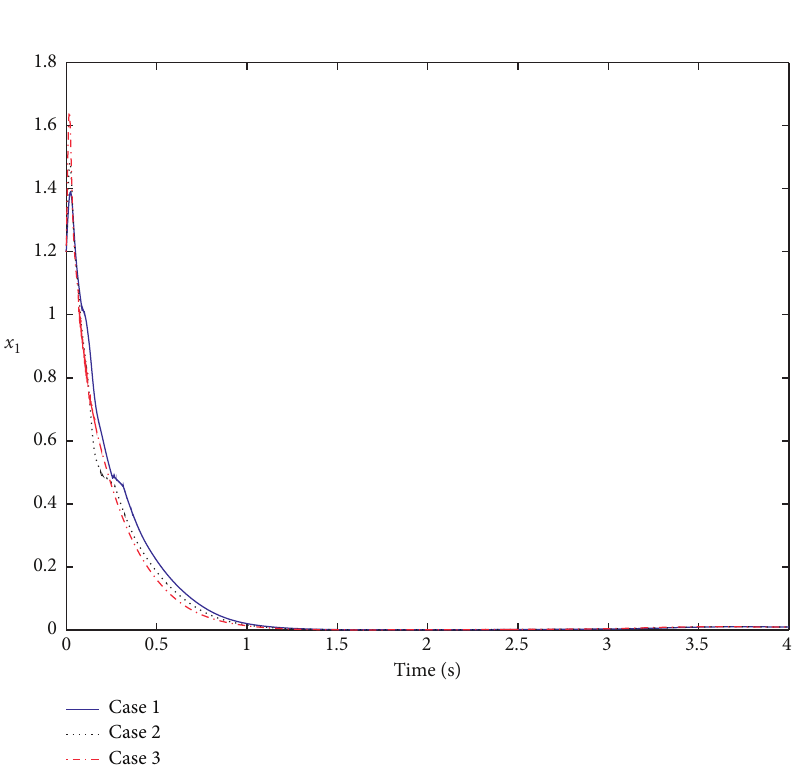
Figure 4: The trajectories of the system state x